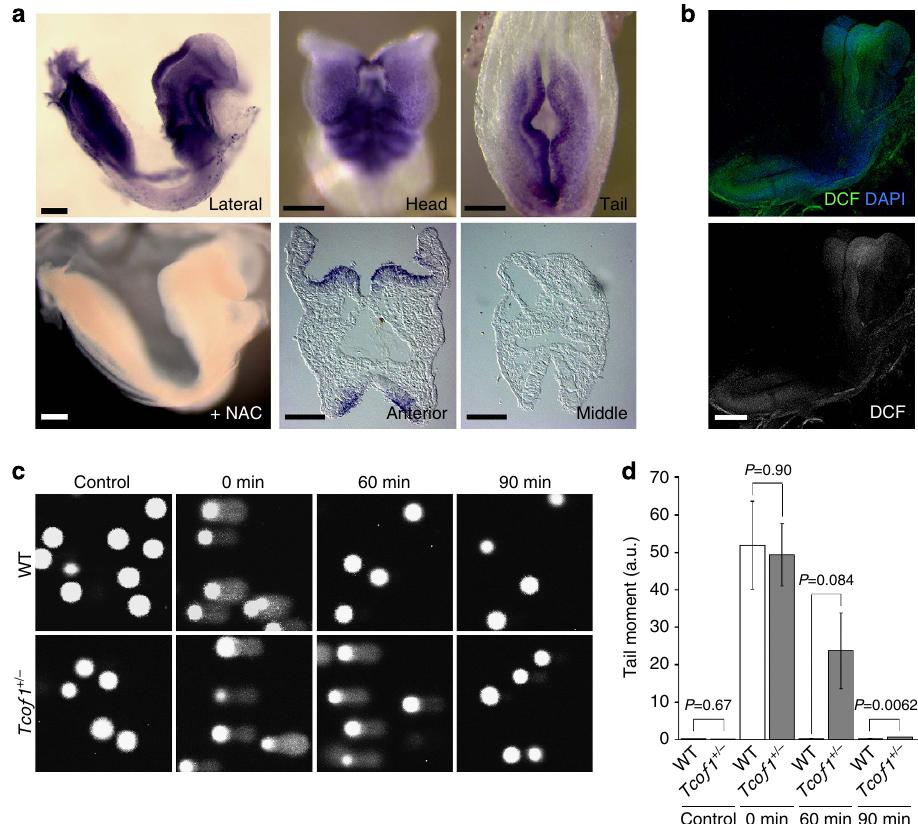
Figure 5 | High levels of oxidation in the neuroepithelium of wild-type embryos. ( a ) Endogenous oxidation was visualized by reduction of NBT. NBT formazan is detected in anterior (head) and posterior (tail) regions of the neural plate. Sections at fore–midbrain level (anterior) show the specific staining of neuroepithelial cells. NBT staining was not detected at the lower cervical level (middle). Treatment with antioxidant, NAC prevents formation of NBT formazan, indicating specificity of NBTstaining. Scale bar, 100 m m. ( b ) Endogenous ROS were visualized by incubation with fluorogenic probe, H 2 -DCFDA. Fluorescence of DCF was shown. Scale bar, 100 m m. ( c ) Time-course kinetics of DNA damage repair in wild-type (WT) and Tco f 1 þ / (cid:2) MEF cells treated with or without H 2 O 2 was analysed by alkaline Comet assay. ( d ) Tail moment is determined by OpenComet and presented as mean ± s.e. of 50 cells from three independent experiments. Statistical differences were assessed with Student’s t -test, and P values were